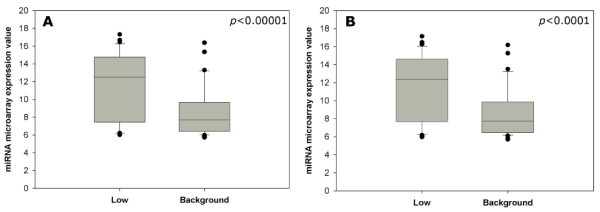
Association of miRNA expression with extent of predicted effect upon target mRNA expression in adult murine retina. Expression of those miRNAs with a significant effect (p < 0.1) upon target gene expression ('low' group) was significantly higher than that of those miRNAs with no predicted effects ('background' group). Microarray data from Loscher et al [13] was available for two strains of mouse, C57 (A) and 129 (B), and both showed a similar result.